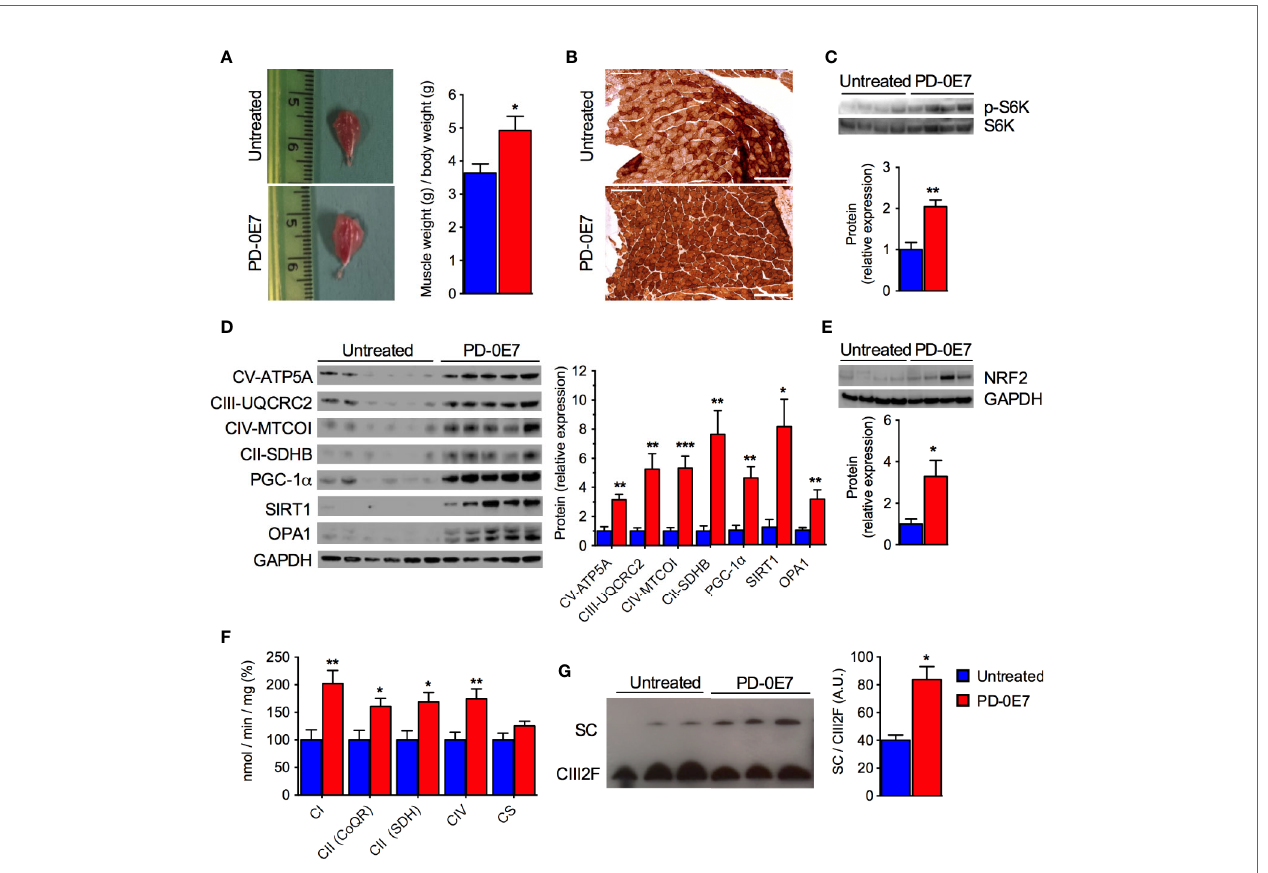
FIGURE 5 | Effect of PD-0E7 on mitochondrial function in skeletal muscle of aged SAMP8 mice. (A) Representative pictures of gastrocnemius muscles of untreated and PD-0E7-treated mice; quanti fi cation of muscle weight/body weight is shown on the right (blue bars, untreated mice, red bars, PD-0E7-treated mice). (B) Representative image of histochemical COX-IV staining in the gastrocnemius muscle of untreated and PD-0E7-treated SAMP8 mice. (C) Western blot analysis of phosphorylated p70 S6 kinase 1 (p-S6K) and total S6K in quadriceps femoris ; quanti fi cation of pS6K/S6K ratio is shown below the image. (D) Western blot analysis of PGC-1 a , SIRT1, OPA1, and of the respiratory chain subunits ATP5A, UQCRC2, MTCOI, and SDHB in quadriceps femoris ; relative quanti fi cation of proteins to GAPDH levels is shown on the right. (E) Western blot analysis of NRF2-ARE in quadriceps femoris , with quanti fi cation relative to GAPDH shown below the image. (F) Biochemical analysis of the enzymatic activities of the mitochondrial respiratory chain (MRC) complex I (CI), complex II (CII), and IV (CIV) in quadriceps femoris PD- 0E7 treated mice compared to untreated controls. (G) Blue native gel electrophoresis on isolated, digitonin-solubilized mitochondria from quadriceps femoris of untreated, and PD-0E7-treated mice showed a stabilization of the complex III into supercomplexes (SC); immunoblot was performed with UQCRFS1 antibody; quanti fi cation is shown on the right. All color codes as in (A) . Statistical analysis was performed with Student ’ s t test. Error bars represent SEM; n=6 mice/group; *p < 0.05, **p < 0.01, ***p <